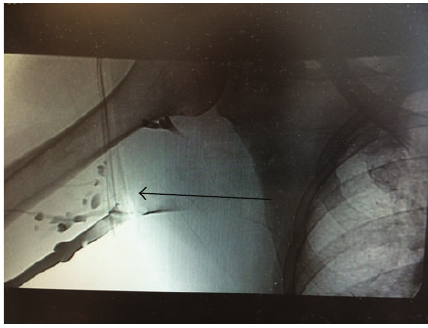
Figure 4: Successful venolysis. Chronic scarring of the right subclavian